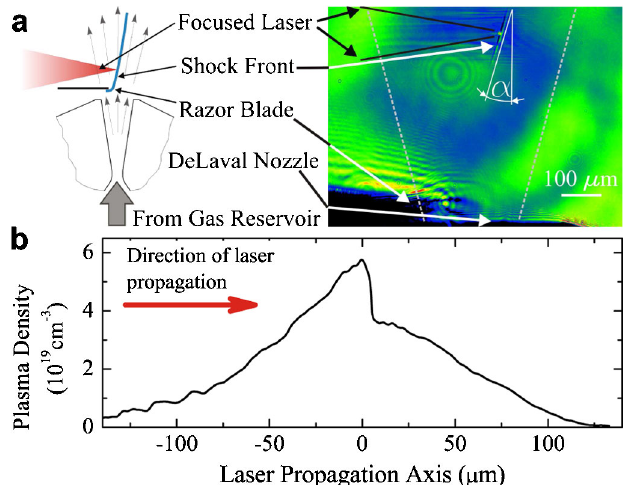
FIG. 1. Sketch and shadowgraph image of the target setup (a). A razor blade is introduced laterally into a supersonic gas jet (undistorted gas jet edges: white dashed lines) in order to generate a shock front (blue line). The shadowgraph image was taken during the experiments showing the nozzle tip, the razor blade (slightly tilted), and the plasma produced by the driving laser. Inside the plasma the tilted shock front can be discerned and a small, bright spot indicative of electron injection is visible. (b) Measured electron density along the laser propa- gation